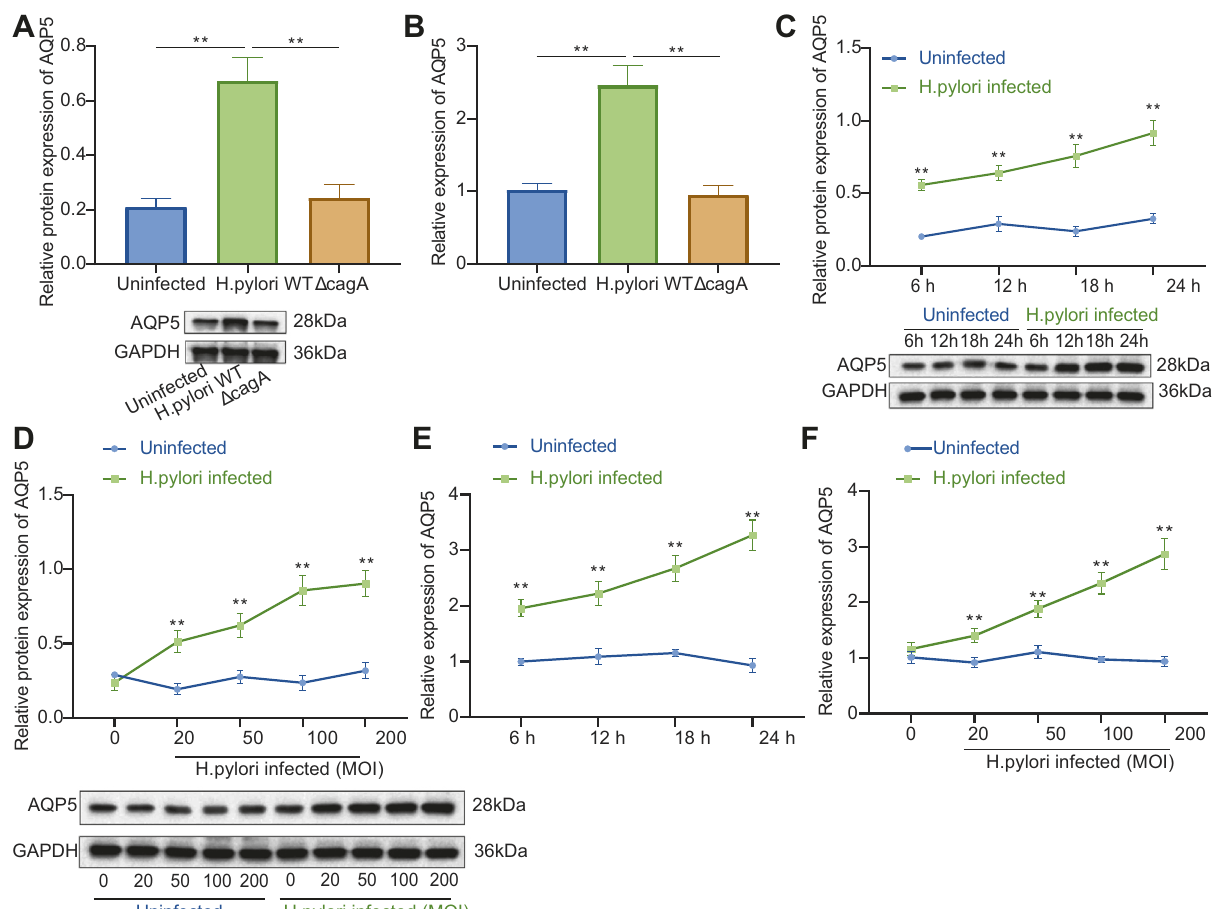
Fig. 2 H. pylori infection enhances AQP5 expression in mouse GECs. A AQP5 protein level in mouse primary GECs measured by Western blot analysis. B , AQP5 mRNA level in mouse primary GECs measured by RT-qPCR. C , D , AQP5 protein level in mouse primary GECs at different time points ( C ) and doses ( D ) measured by Western blot analysis. E , F , AQP5 mRNA level in mouse primary GECs at different time points ( E ) and doses ( F ) measured by RT-qPCR. * p < 0.05, ** p < 0.01. Data were shown as the mean ± standard deviation. Cell experiments were repeated three times independently. Comparisons of data between two groups were analyzed by independent sample t- test. One-way ANOVA with Dunnett ’ s post hoc test was applied for the comparison of data among multiple groups. The data between groups at different time points were compared by repeated measures